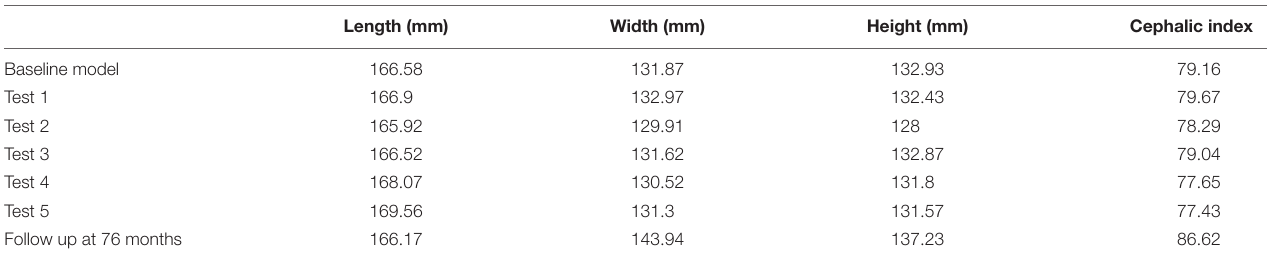
TABLE 2 | Material property and bone formation rate sensitivity